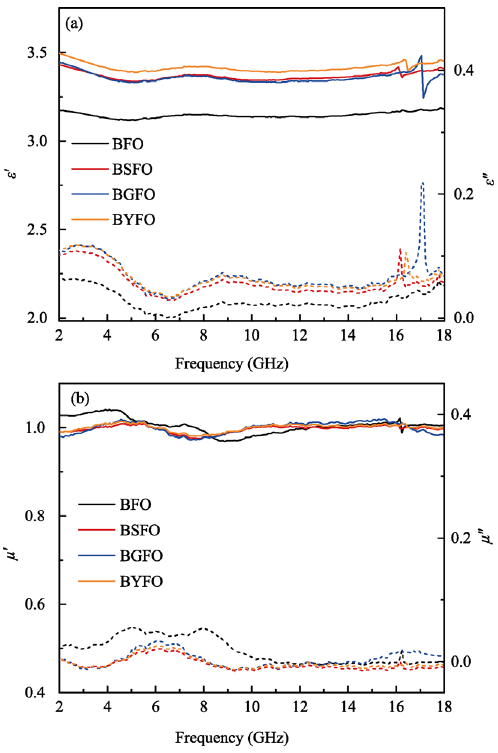
Fig. 5 (a) Real and imaginary parts of permittivity and (b) real and imaginary parts of permeability of BFO, BSFO, BGFO, and BYFO,